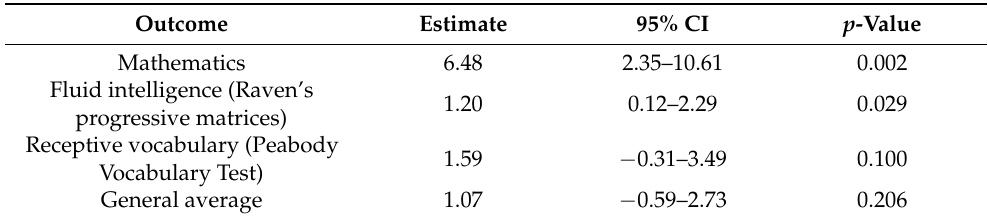
Table 3. Estimates of the fixed effects for the cognitive tests and academic average. Estimates shown for children that attended the Guatemala City Municipal